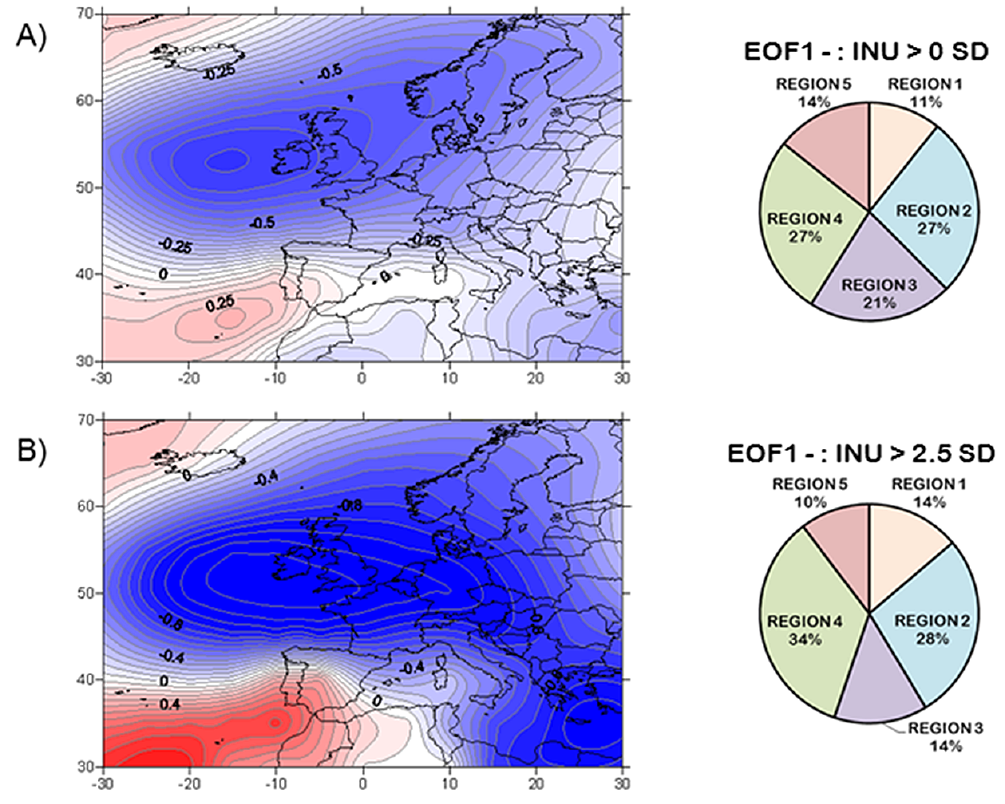
Figure 12. As in Fig. 11 but for EOF1 negative phase. Region 1 encompasses Valais and western cantons, region 2 the western part of the northern slope of the Alps and the Swiss Plateau, region 3 Grisons plus the southern flank of the Alps, region 4 eastern Jura and the Swiss Plateau and region 5 encompasses the eastern part of the northern flank of the